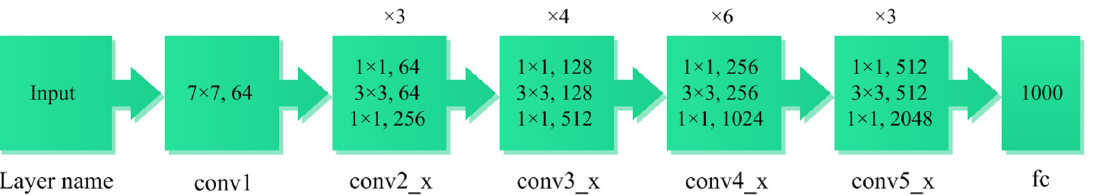
Figure 3. The overall framework of ResNet-50. Herein, the residual building blocks are expressed in green boxes and their number is displayed above the